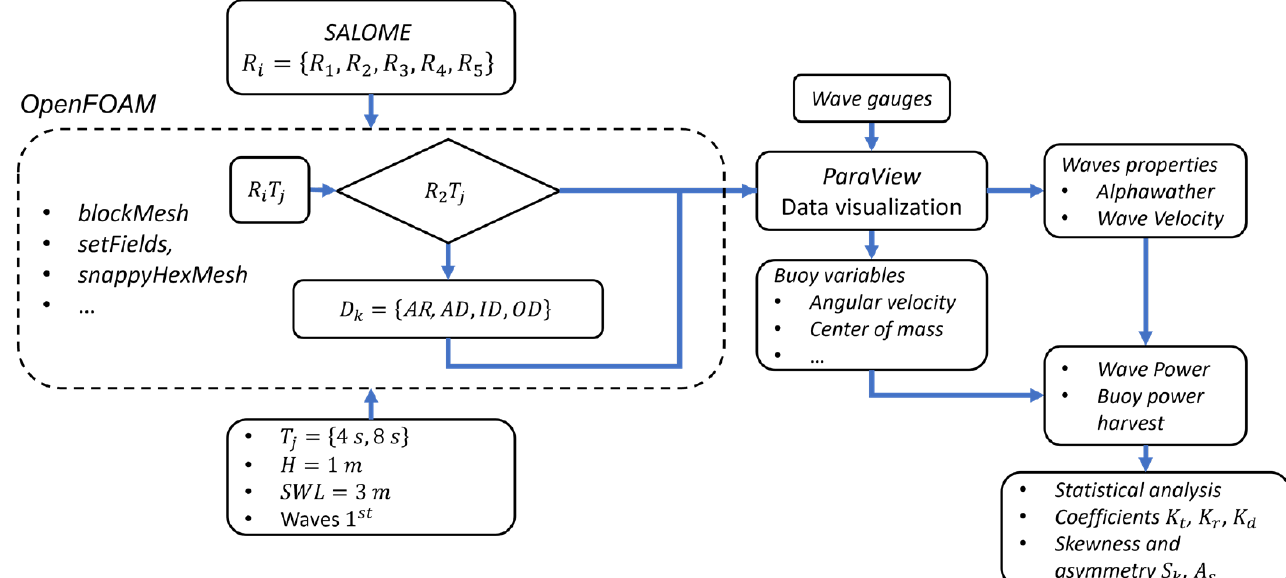
Figure 3. Schematic representation of the cylindrical buoy’s WEC implementation process.